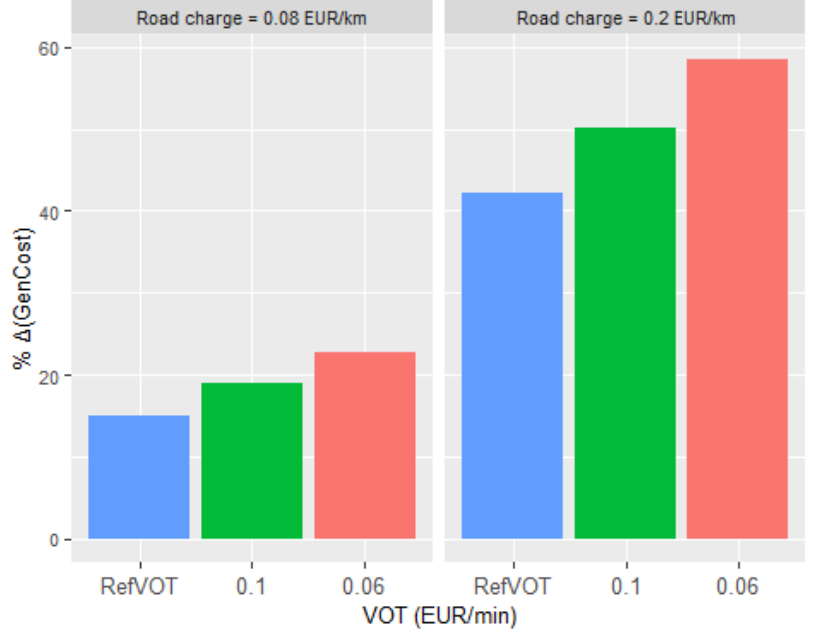
Figure 11. Road charge : changes in generalised cost compared to central scenario